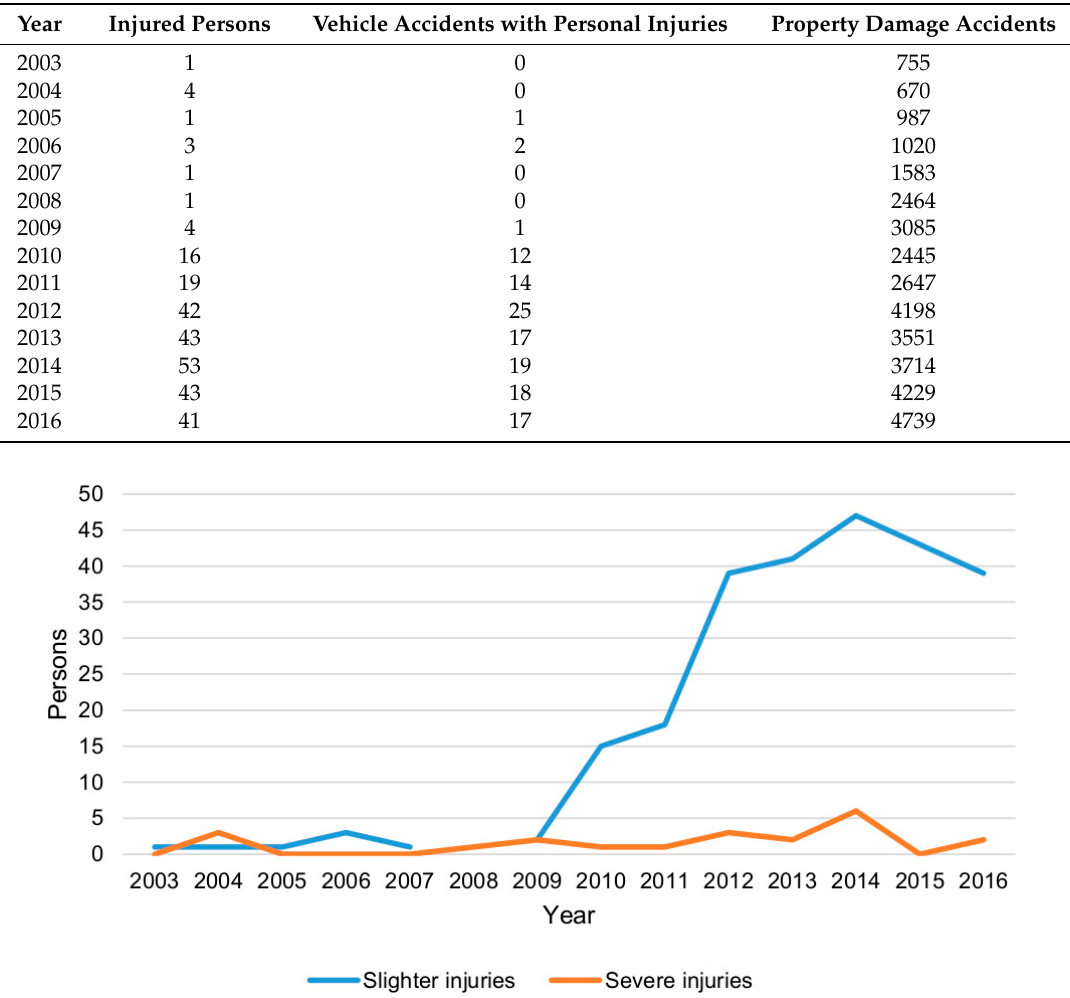
Figure 3. The number of injured persons (slighter and severe injuries) in wild boar-vehicle accidents in Sweden 2003–2016. Data comes from STRADA.